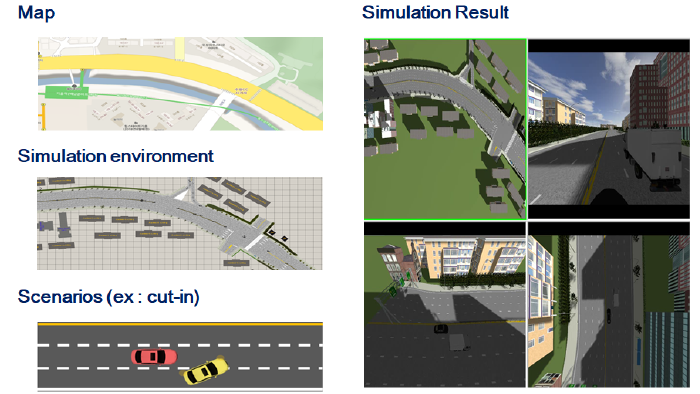
Figure 3. Selection of driving routes and simulating driving situations.